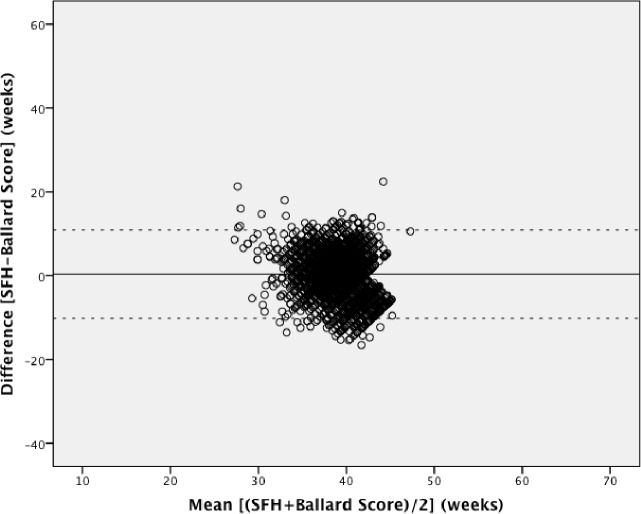
Post-hoc Bland-Altman plot: Last menstrual period versus the New Ballard Score.Mean difference (solid line) and 95% limits of agreement (dotted line).